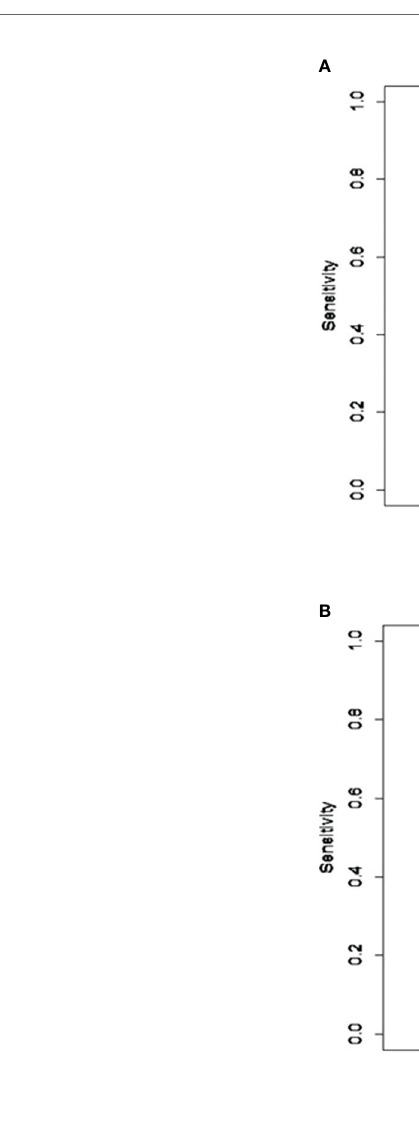
FIGURE 4 | (A) ROC curves of the PTFM in the training set (green curve) and test set (red curve). (B) ROC curves of the ALNFM in the training set (green curve) and test set (red